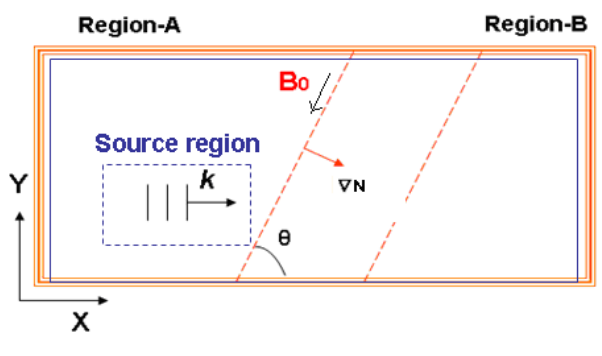
Fig. 3. Schematic illustration of the simulation system. We assume homogenous regions with plasma frequencies of ω pA (Region-A) and ω pB (Region-B) smoothly connected by an inhomogeneous re- gion where the density gradient ∇ N is